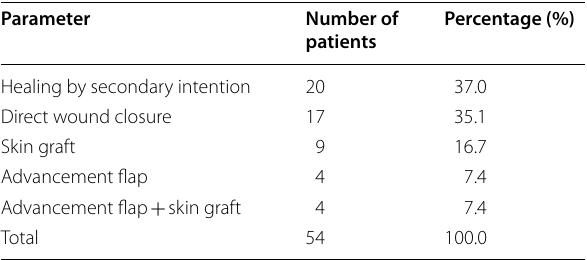
Table 2 Options of management of peno‑scrotal wound